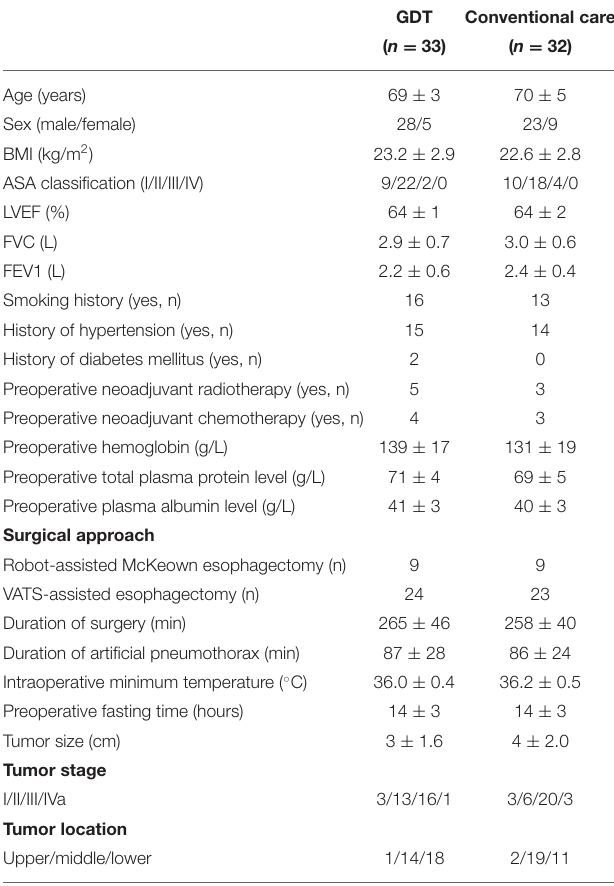
TABLE 1 | Demographics and clinical characteristics of the study population.